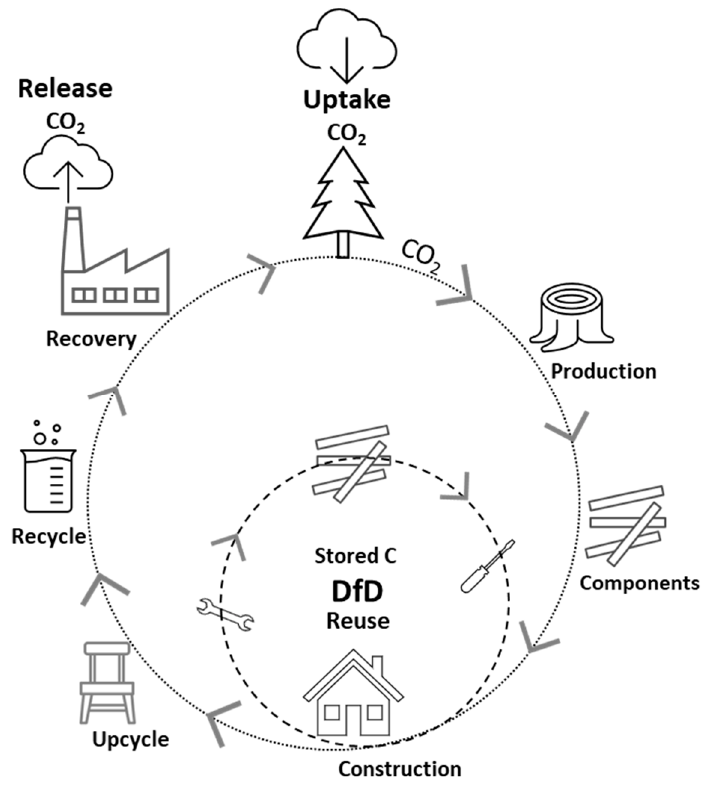
Figure 3. Life cycle of renewable materials and cascade use of biomaterials.